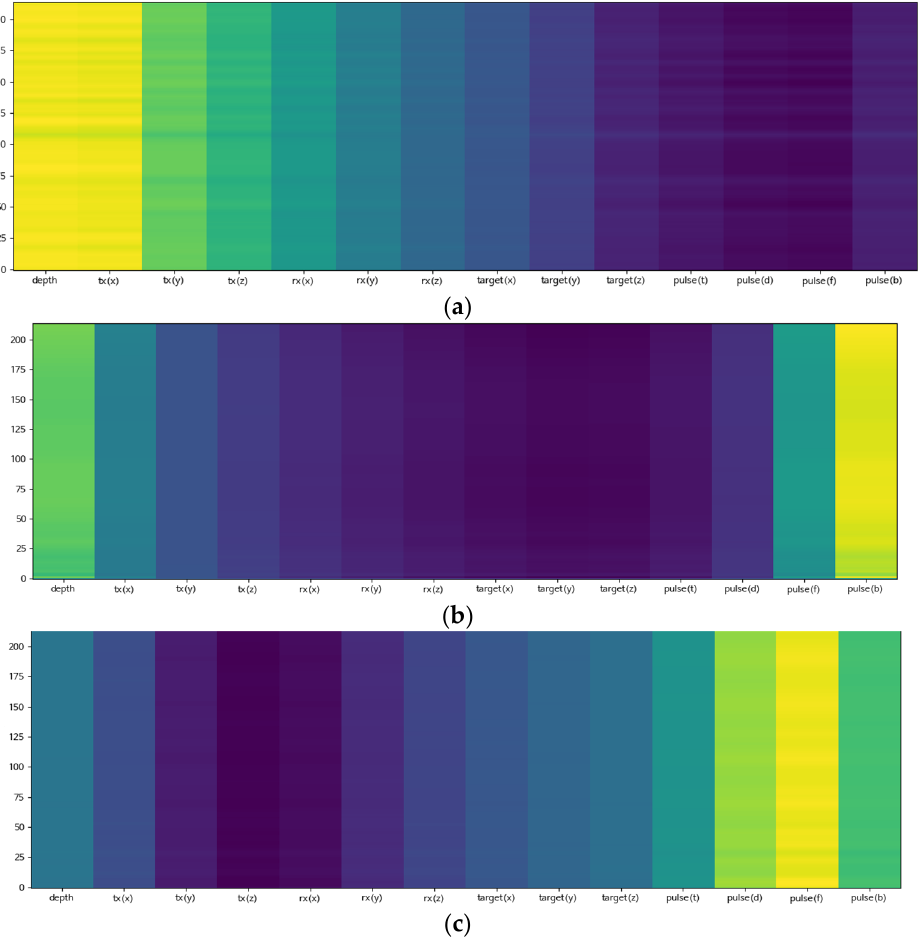
Figure 12. Attention alignments in the test. ( a ) Training only depth parameters. ( b ) Training only pulse center frequency parameters. ( c ) Training only pulse duration parameters. (c) The MOS score. Table 4. The MOS